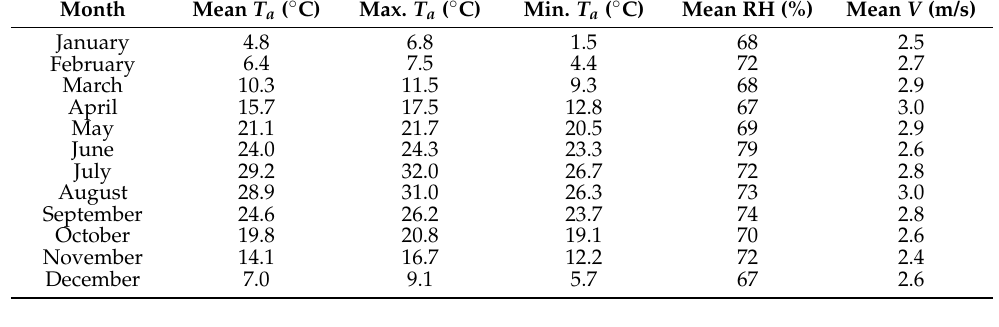
Table 1. Monthly T a , RH, and V in Shanghai from the year 2000 to 2010.